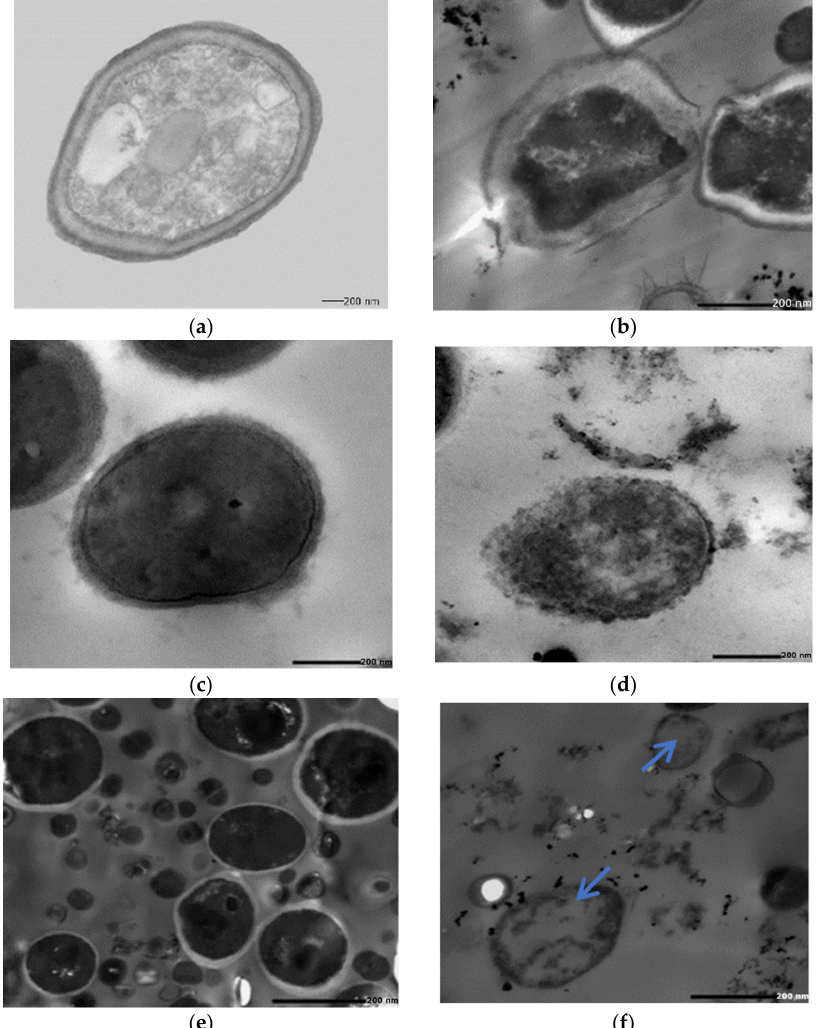
Figure 6. Transmission electron microscope study of C. albicans DAY185 control ( a ), C. albicans DAY185 treated with Mo-capped AgNPs ( b ), S. aureus ATCC 6538 control ( c ), S. aureus ATCC 6538 treated with Mo-capped AgNPs ( d ), consortia control ( e ), and consortia treated with Mo-capped AgNPs ( f ). Blue arrow: ghost cells.